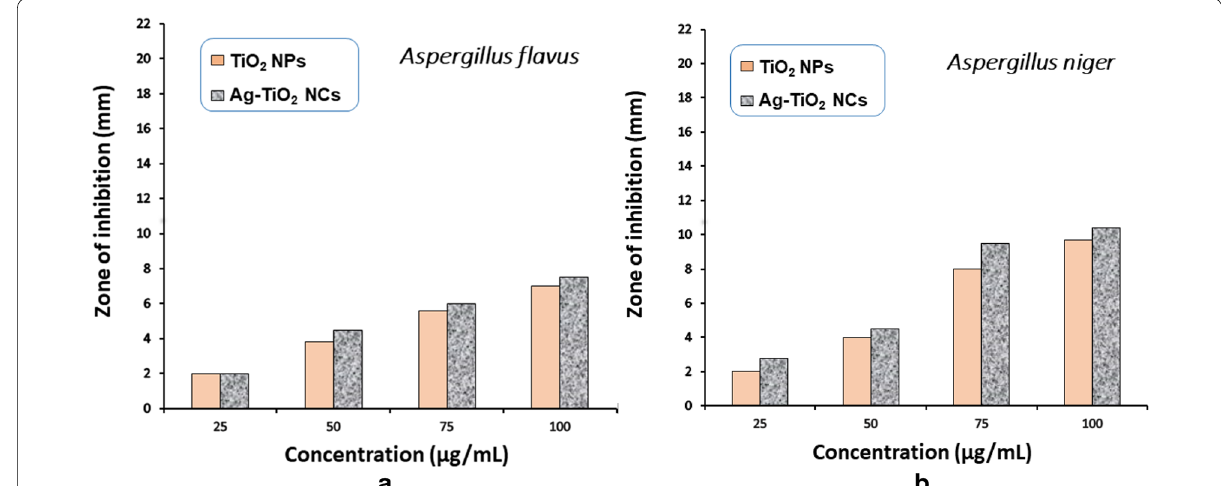
Fig. 7 Antifungal activity of green-synthesised Ag–TiO 2 NCs and TiO 2 NPs at different concentrations against two fungi a A. flavus and b A. niger